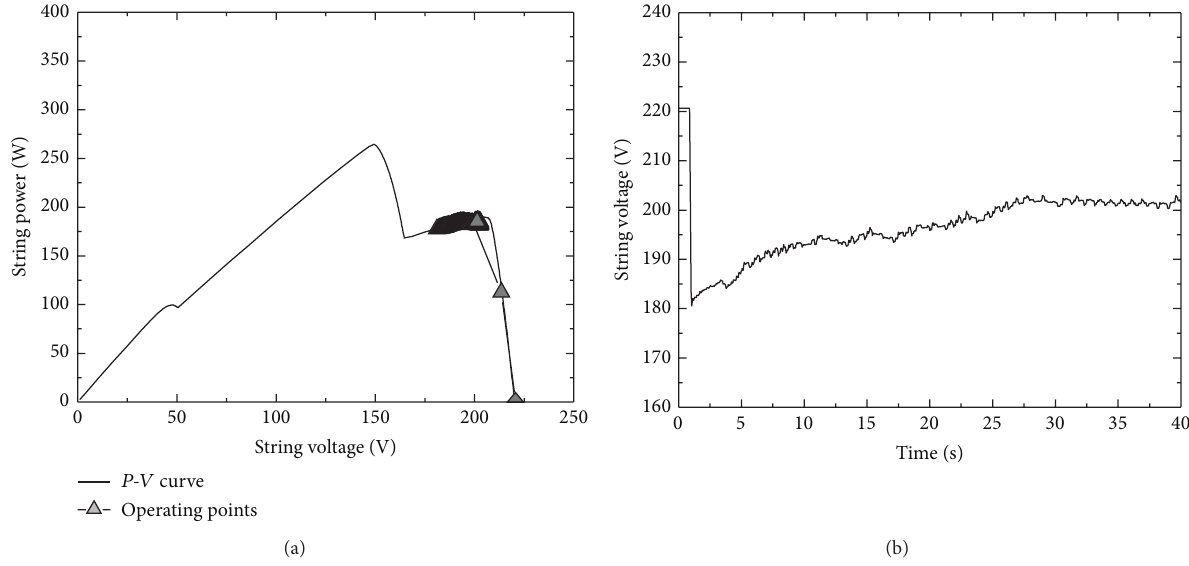
Figure 13: Partial-shading case. (a) Experimental power-voltage characteristic (solid line) of the 10-panel test string under partial-shading conditions. The operating points of the string (triangles) by adopting a classical P&O algorithm are shown. (b) String power against the